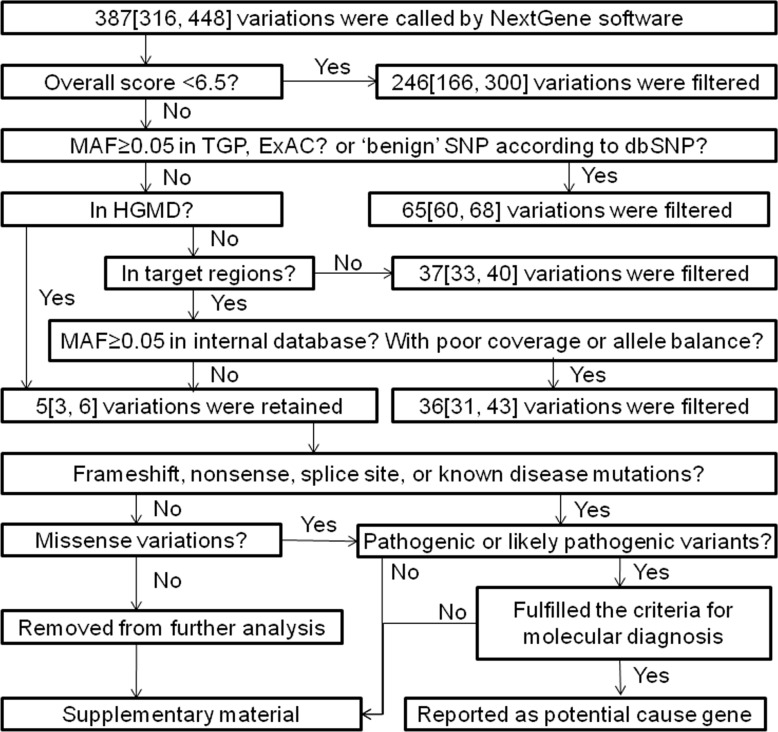
The optimized protocol for panel sequencing data analysis.The data from 195 patients were presented as median [P25, P75]. MAF, minor allele frequency; TGP, 1000 Genomes Project; ExAC, Exome Aggregation Consortium; dbSNP, Single Nucleotide Polymorphism database; HGMD, Human Gene Mutation Database.